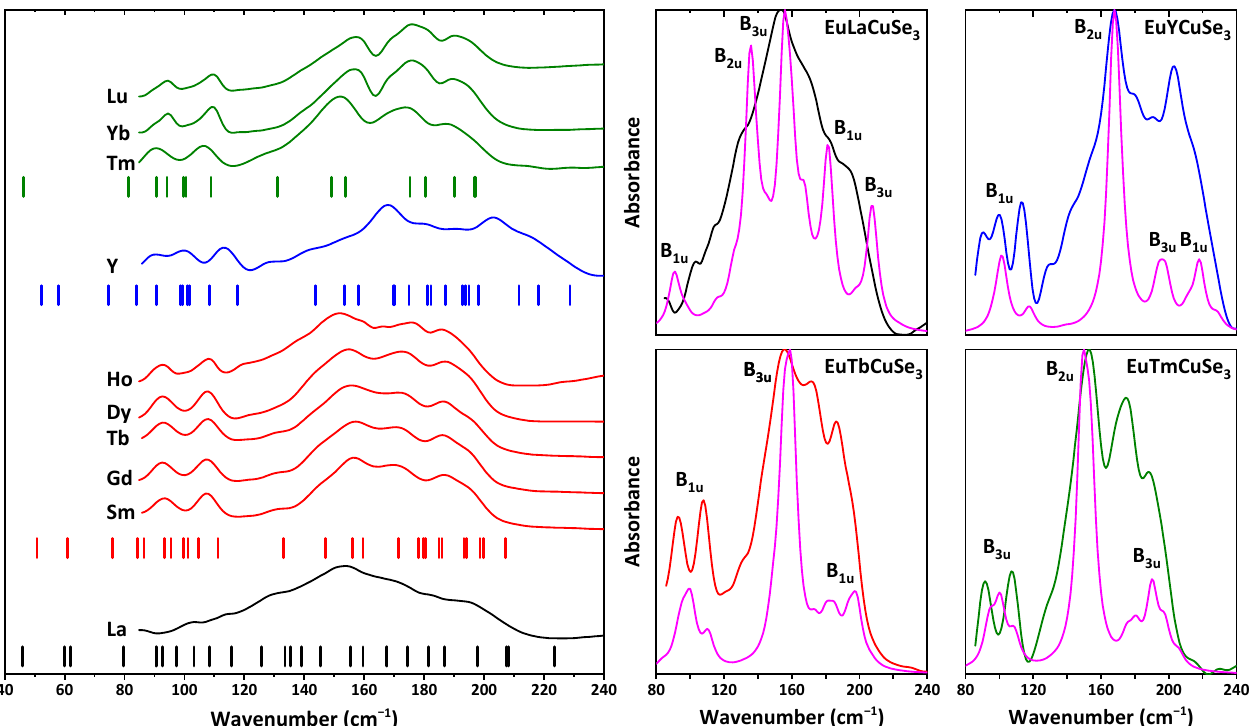
Figure 8. ( left ) IR spectra of EuLnCuSe 3 . Ticks stand for the calculated wavenumbers for EuLaCuSe 3 (structural type Ba 2 MnS 3 ), EuSmCuSe 3 and EuYCuSe 3 (structural type Eu 2 CuS 3 ) and EuTmCuSe 3 (structural type KZrCuS 3 ) in Table S10 in the Supplementary Materials. ( right ) The calculated (magenta) and experimental IR spectra of EuLaCuSe 3 (black), EuTbCuSe 3 (red), EuYCuSe 3 (blue) and EuTmCuSe 3 (green).